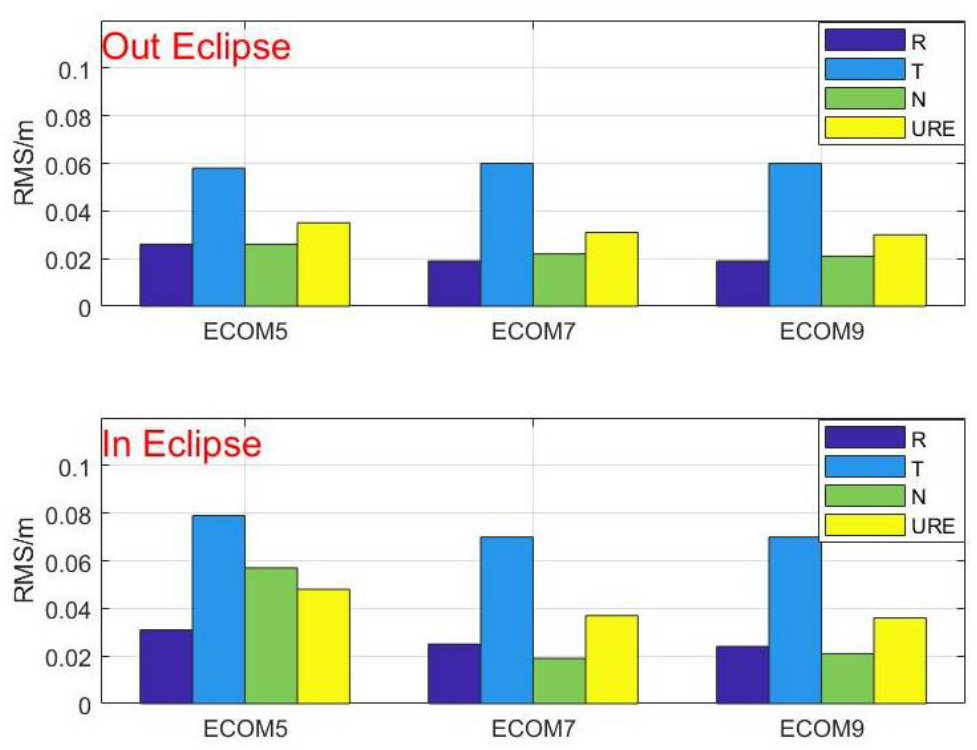
Figure 7. Accuracy of BDS-3 predicted orbits with different ECOM SRP models when satellites move in and out of eclipse seasons (6 h prediction interval).